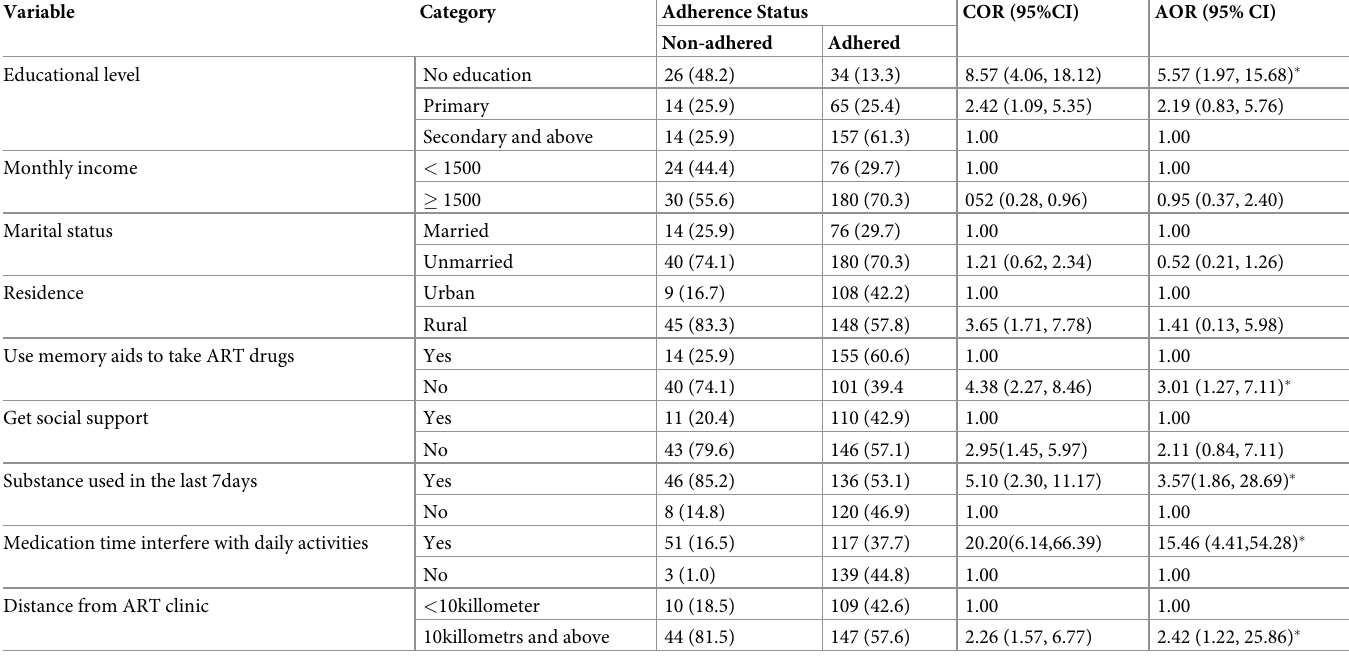
Table 4. Factors associated with non-adherence among adult on first-line ART follow up at public health facilities of North Shewa Zone, Amhara Regional State, Ethiopia, 2019.